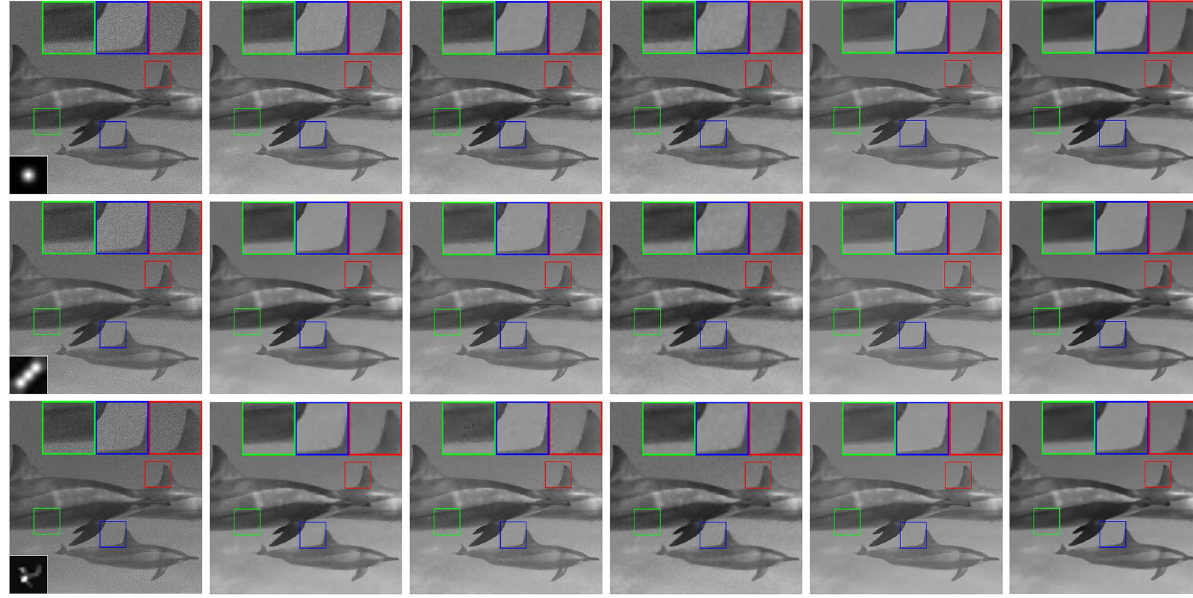
Fig 4. Restored “dolphin” images and zoom-in regions from the degraded images with different blur kernels and the Poisson noise of level MAX = 200. first row: Gaussian blur; second row: motion blur; third row: ground truth blur; first column: degraded images (PSF is shown at the bottom-left corner); second column: restored images by SB-FA [38]; third column: restored images by SAHTV [5]; fourth column: restored images by TVOGS [4]; fifth column: restored images by FT-ADMM [37]; sixth column: restored images by HTVp-OGS.